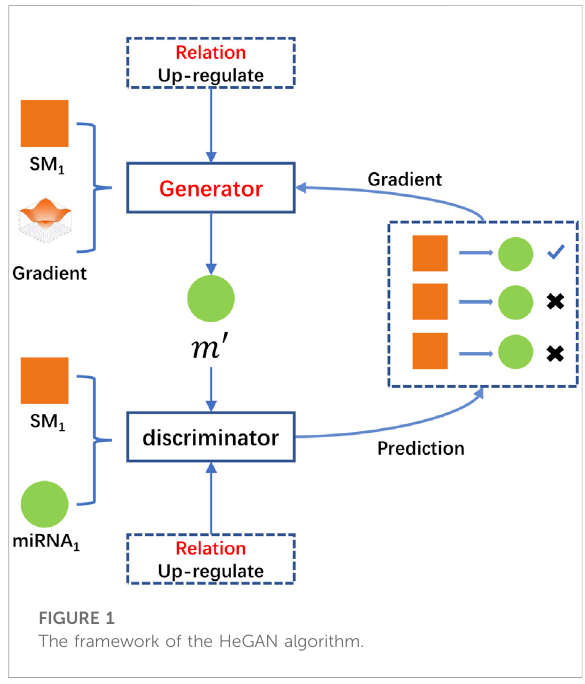
FIGURE 1 The framework of the HeGAN